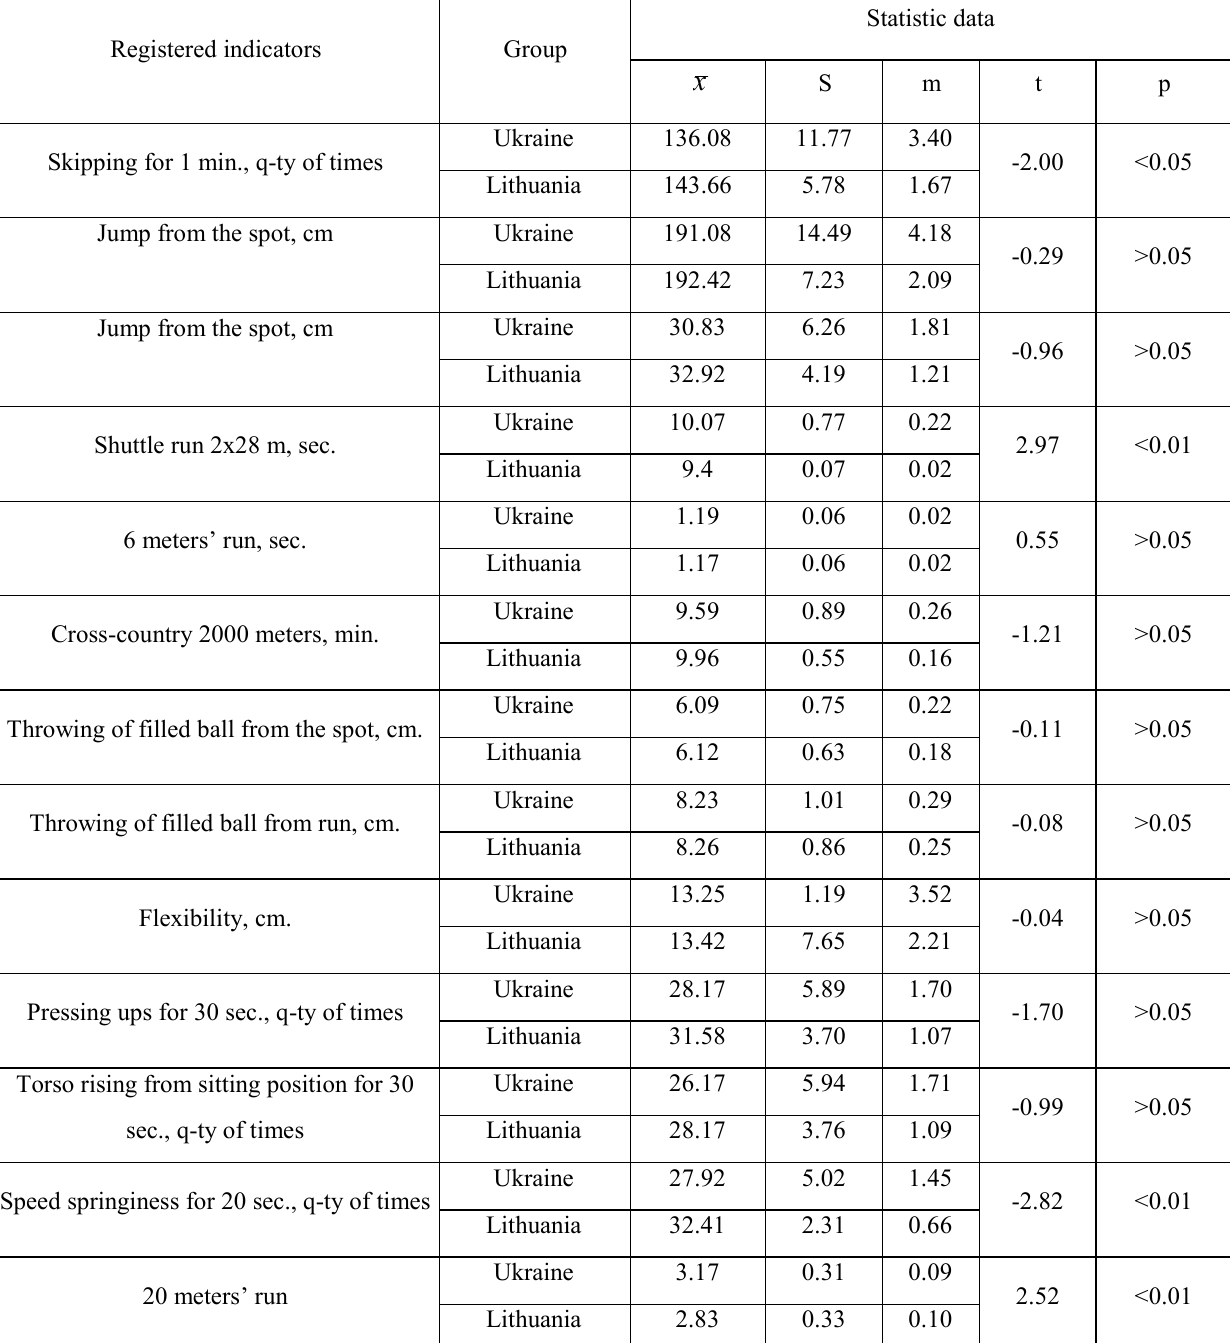
Physical fitness indicators of control (n=12) and experimental (n=12) groups’ female basketball players